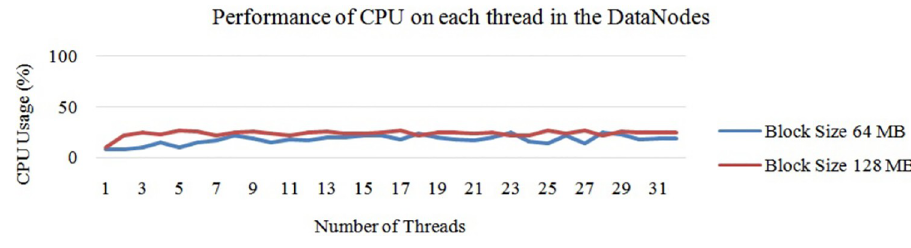
Fig 12. Average usage of Hadoop on large data-set with different block